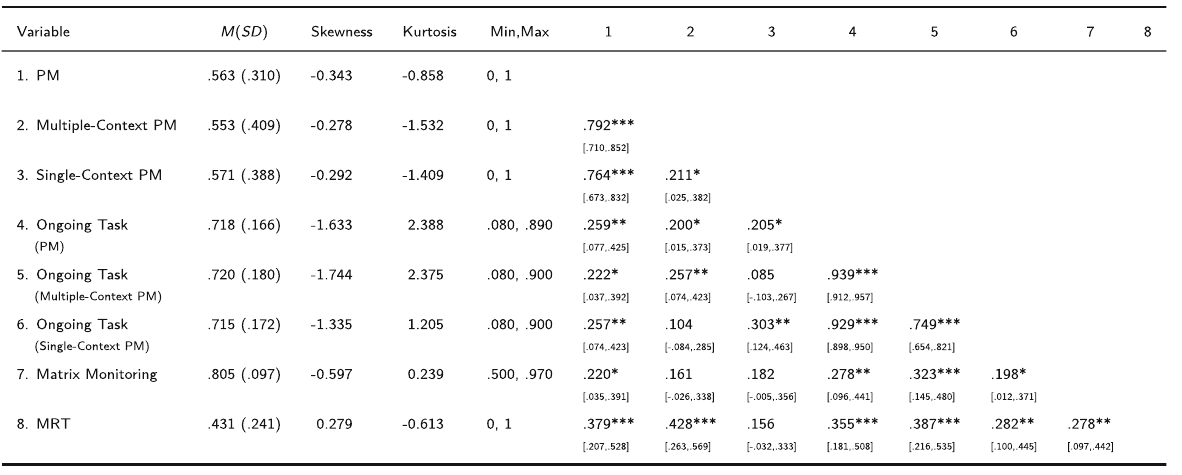
Table 1 Descriptive statistics of all measures and their correlations ( N =